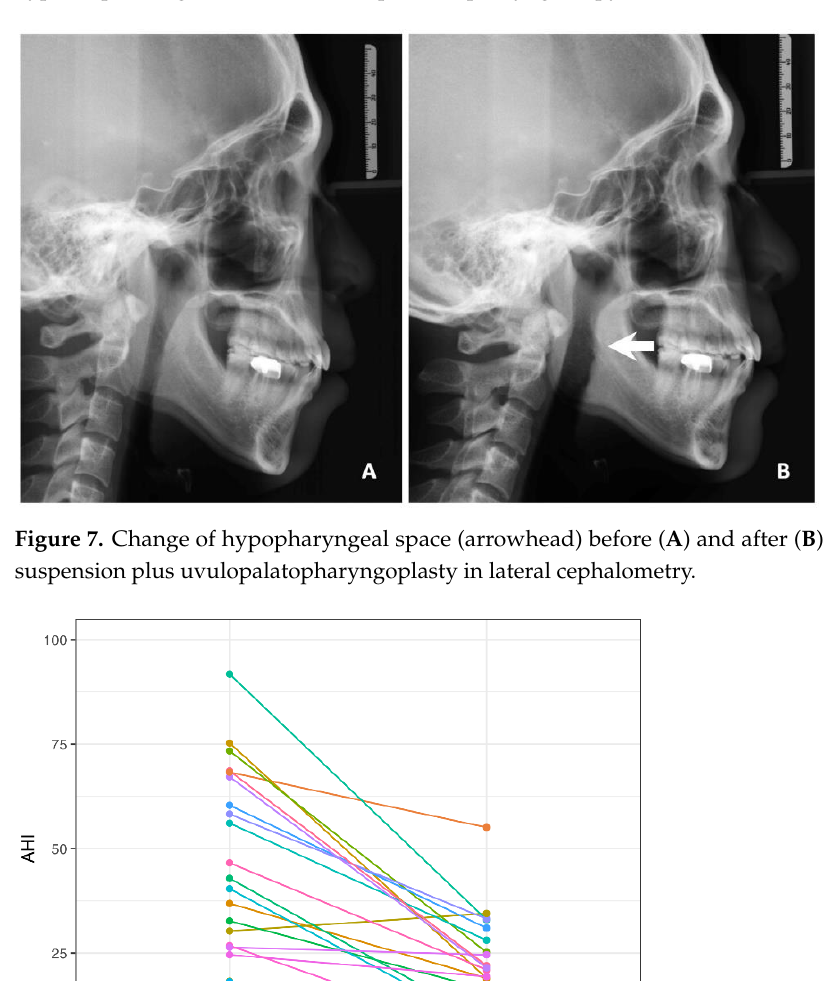
Figure 6. Change of airspace before ( A ) and after ( B ) transoral tongue suspension plus ablation of hypertrophic lingual tonsils in fiberoptic nasopharyngoscopy.